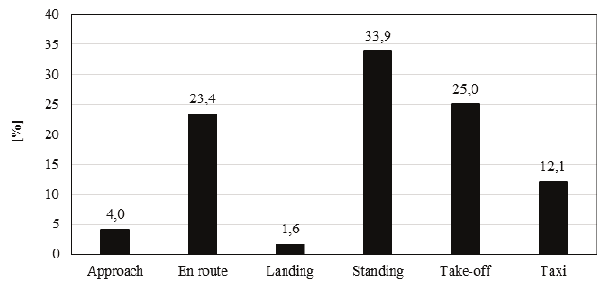
Fig. 28. Flight phase share when turbojet engine malfunction took place